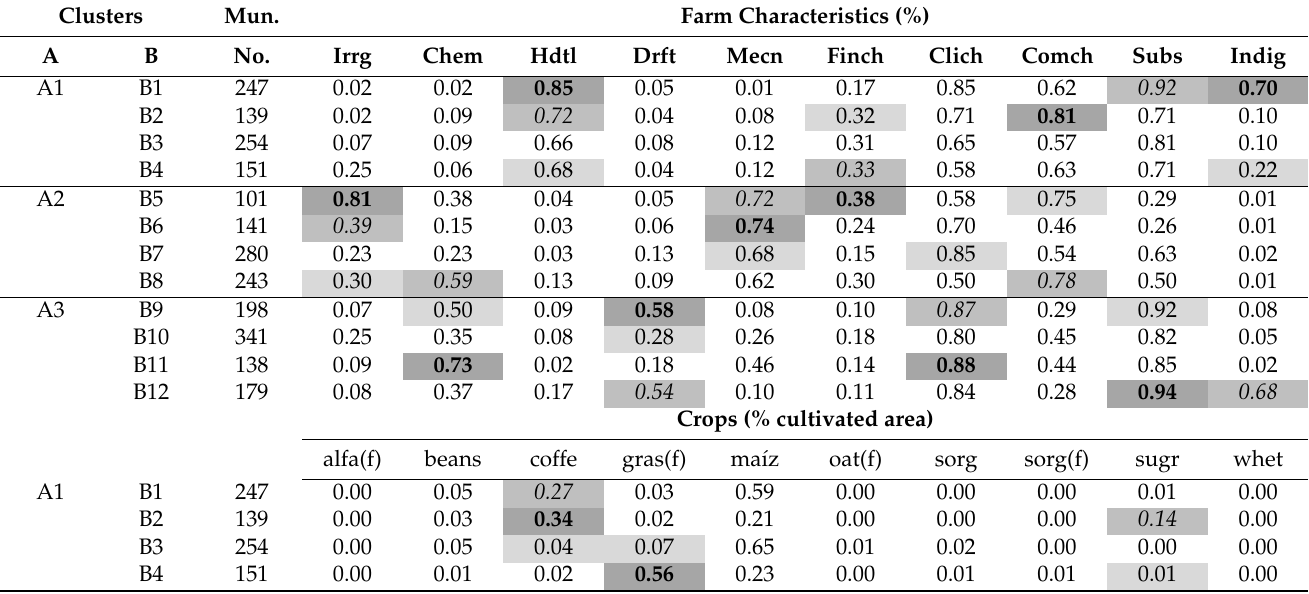
Table 3. Variable means in each cluster (B), shaded by ordered rank and highest (bold), second highest (italics), and third highest (gray-none) values—see Table 1 for explanation of variable codes. Clusters